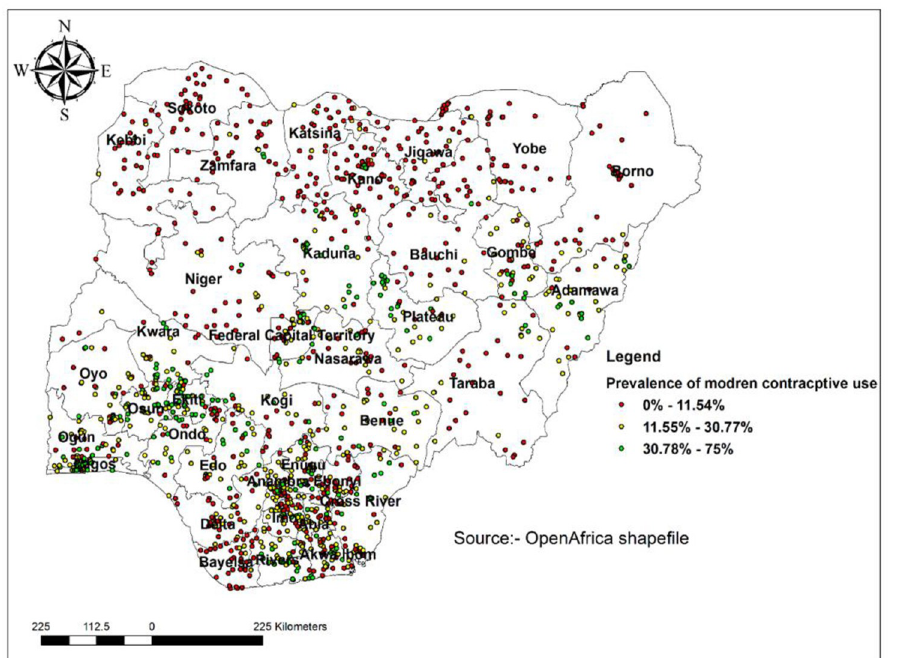
Fig 1. Spatial distribution of modern contraceptive use in Nigeria,